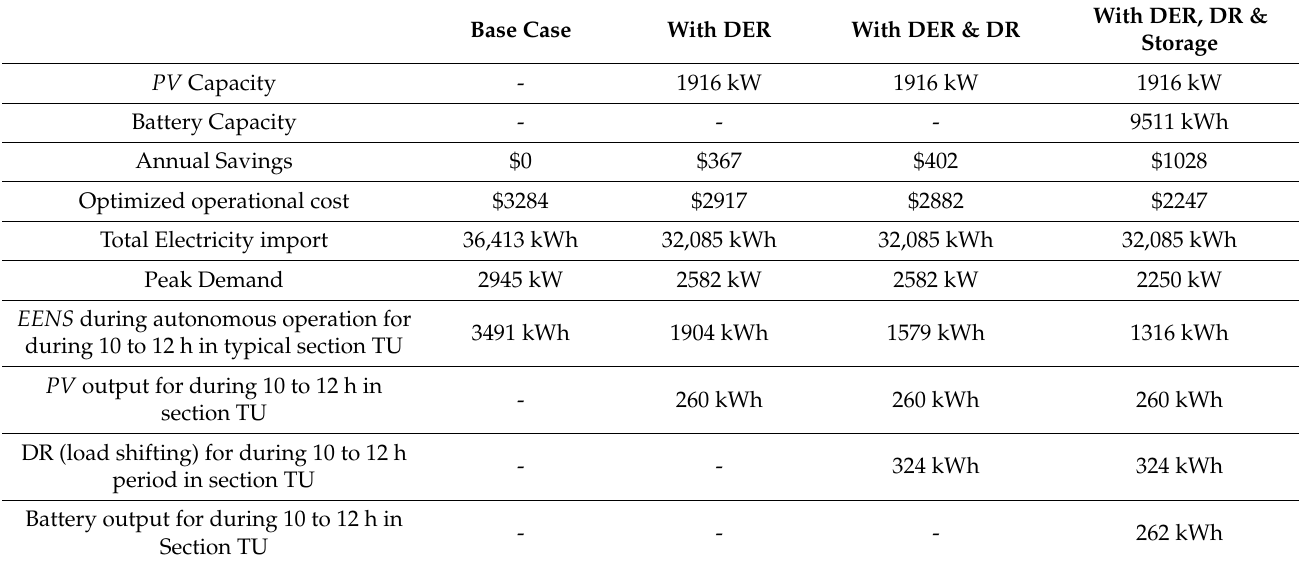
Table 3. VPP Techno-economic analysis.